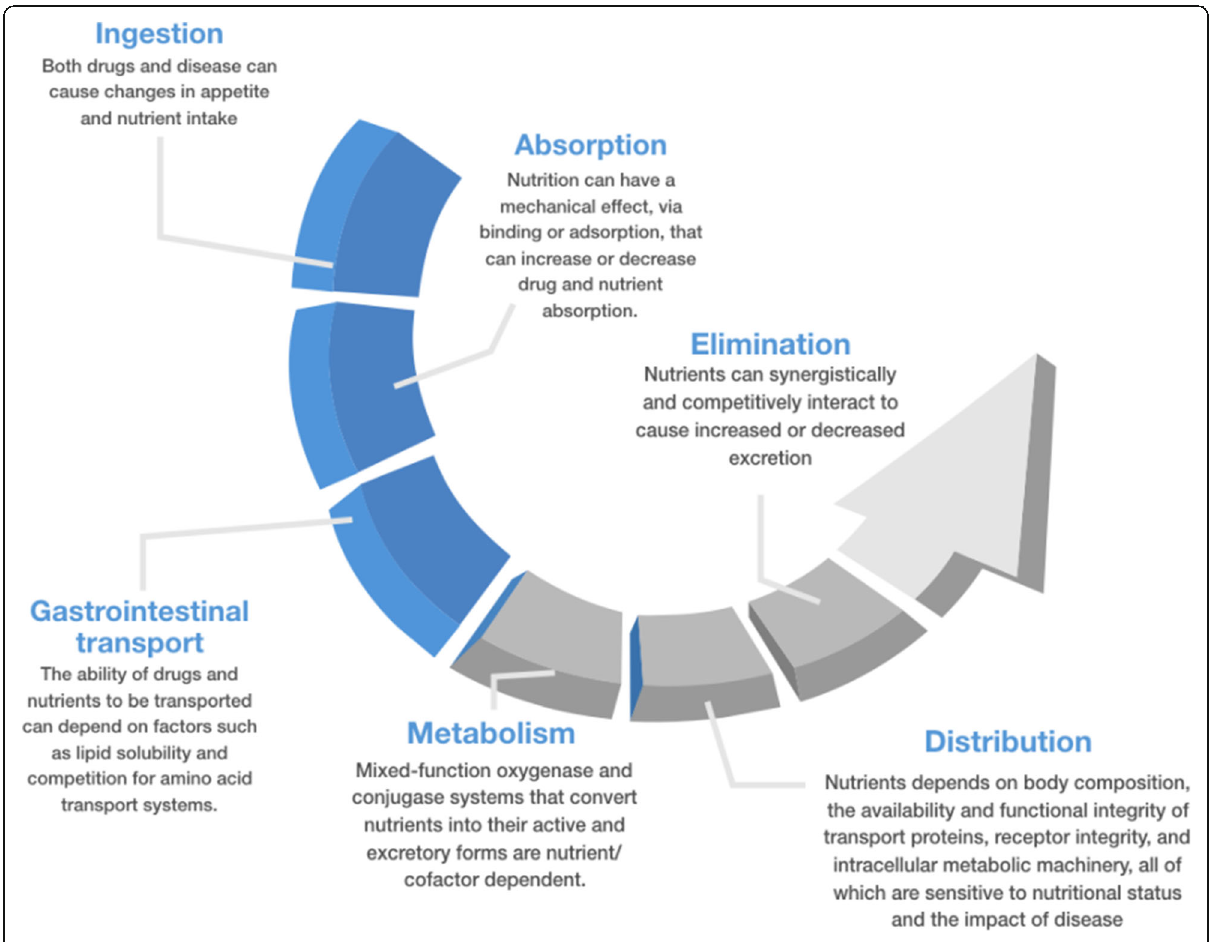
Fig. 1 Potential mechanism of nutrients-drugs